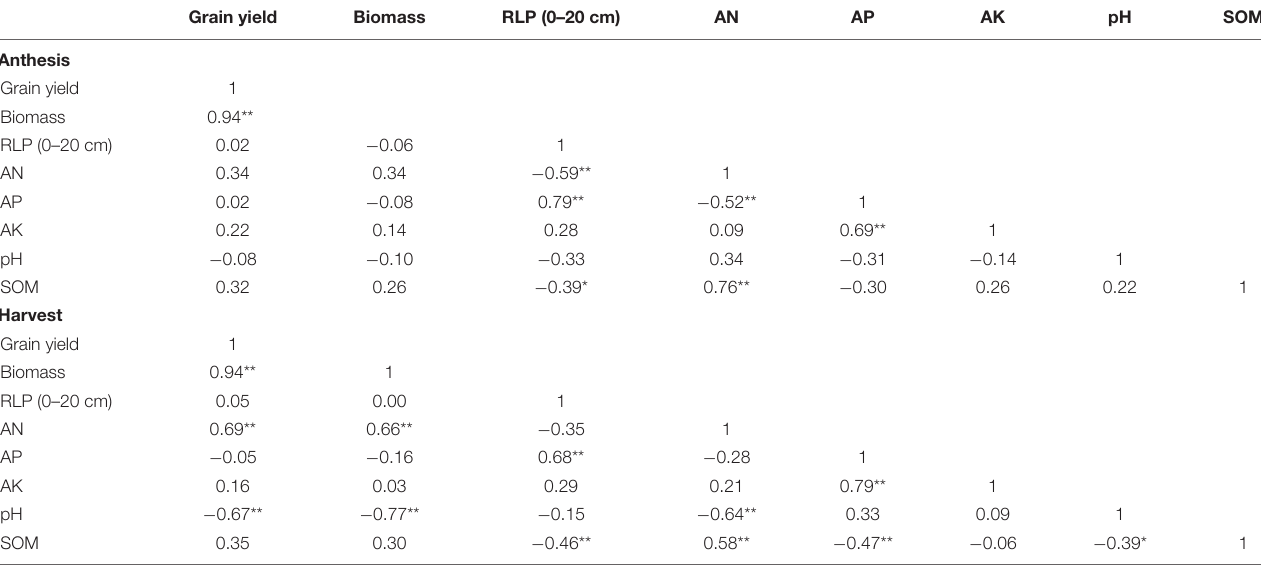
TABLE 3 | Correlation between wheat growth index [grain yield, biomass, root length percentage (RLP)] and soil chemical properties [available N (AN), available P (AP), available K (AK), pH, and soil organic matter (SOM)] at 0–20 cm. Grain yield Biomass RLP (0–20 cm) AN AP AK pH